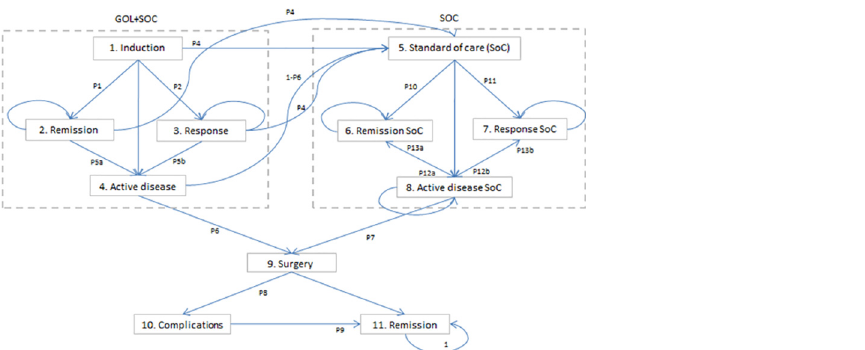
Fig 1. Structure of Markov model for patients with UC.